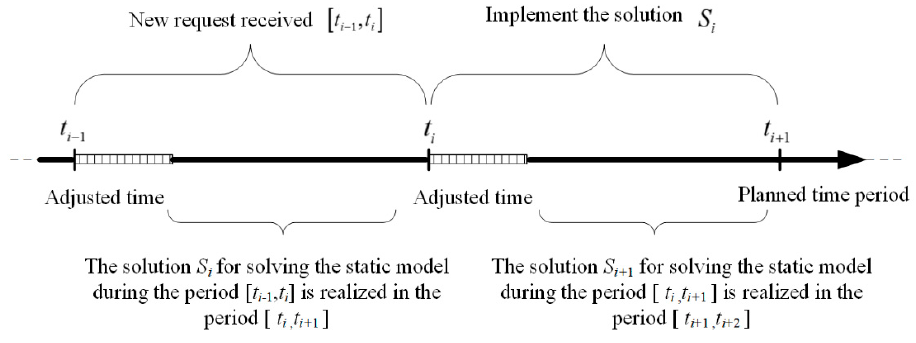
Figure 7. The diagram of the order planning sequence.